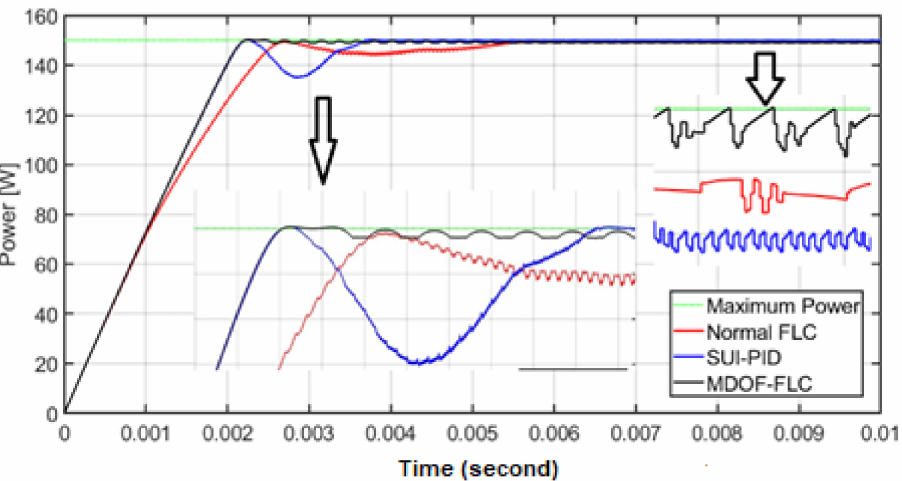
Figure 15. Transient performance at 1000 Watt/m 2 and temperature 25 ◦ C of the three